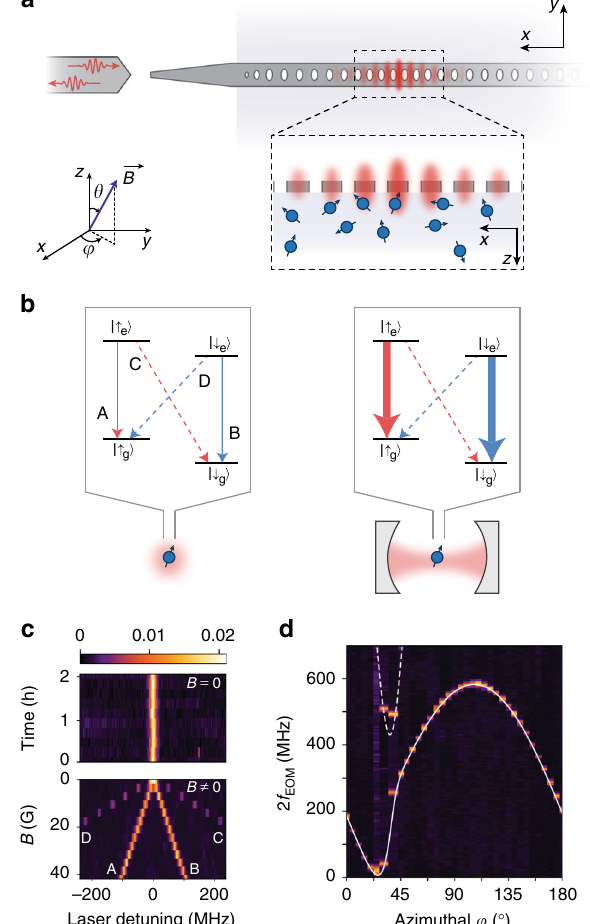
Fig. 1 Experimental approach. a The experimental device is a silicon photonic crystal cavity on top of an Er 3 + -doped YSO crystal. Light in the cavity evanescently couples to the Er 3 + ions. (inset) De fi nition of magnetic fi eld angle ( φ , θ ); ( x , y , z ) refer to the ( D 1 , D 2 , b ) optical axes of the YSO crystal. b Without a cavity, the spin-conserving transitions A, B and spin- non-conserving transitions C, D are comparable in strength. The cavity selectively enhances A,B, resulting in highly cyclic optical transitions. c In the absence of a magnetic fi eld, the four transitions are degenerate and give rise to a single, stable optical transition with a full width at half maximum of 6 MHz (centered at λ = 1536.48 nm). A magnetic fi eld lifts the degeneracy. The color bar denotes the fl uorescence intensity (arbitrary units). d The Zeeman splitting is strongly anisotropic, measured here by applying a 112G magnetic fi eld at various angles φ ( θ = 90 ∘ ) while driving the ion with a phase-modulated laser containing frequencies f 0 ± f EOM , where f 0 is the transition frequency when B = 0. The solid (dashed) line shows the predicted splitting between the A – B (C – D) transitions 29